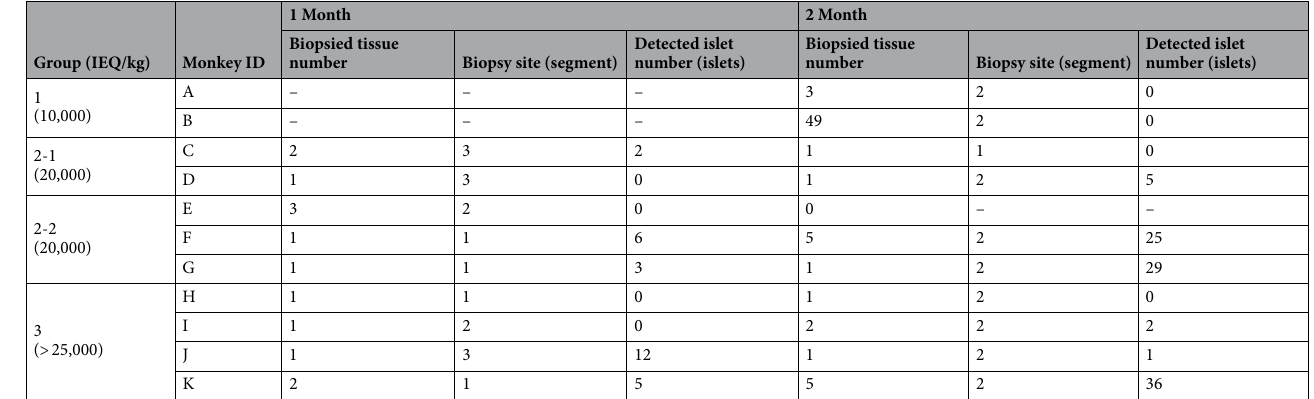
Table 2. Results of liver biopsies and detected islets.